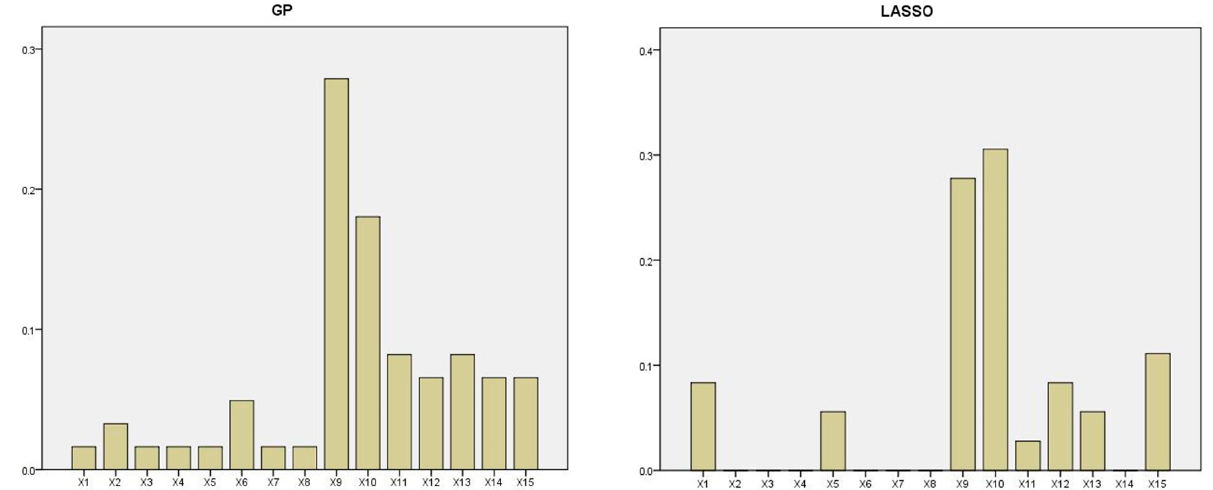
Figure 4. Bar chart with relative frequency of variable selection—genetic programming (GP) vs. the least absolute shrinkage and selection operator (LASSO).